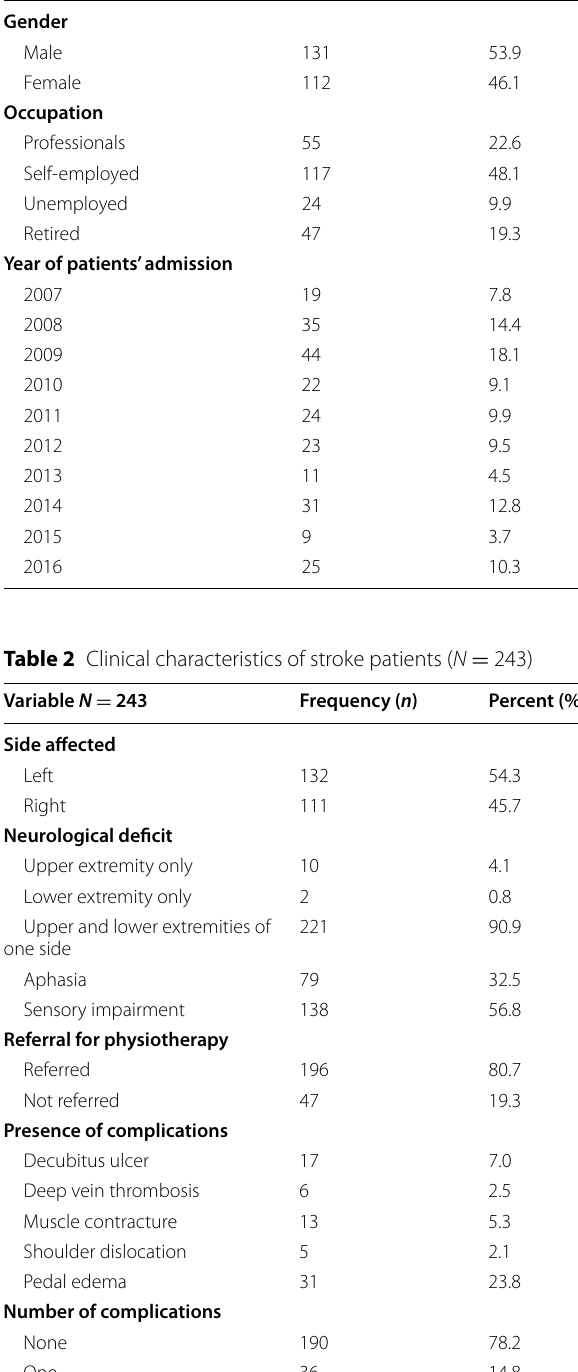
Table 3 Differences in the length of stay between side affected, referral for physiotherapy, utilization of physiotherapy services, presence of complication, and type of